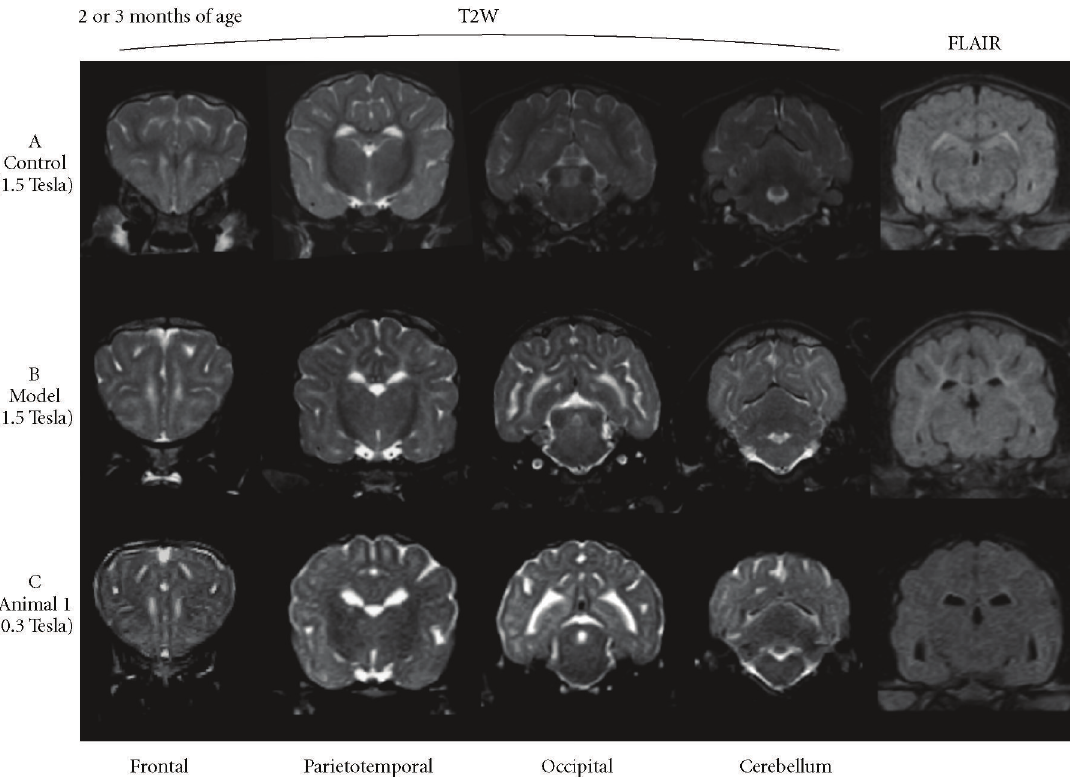
Figure 1: Various transverse sections of T2W and FLAIR images at 2 (A: age-matched control dog (control) and B: a ff ected laboratory dog (model)) or 3 months of age (C: clinical case 1 (animal 1)). T2W hyperintensity in the subcortical white matter of the whole cerebrum was observed in a ff ected dogs (B, C), but almost nonexistent in the control dog (A). T2W hyperintensity was more clearly recognized in B, which was obtained by a 1.5 Tesla system, than in C, which was obtained by a 0.3 Tesla system. In addition, subcortical hyperintensity was di ffi cult to detect on the FLAIR images obtained by a 0.3 Tesla